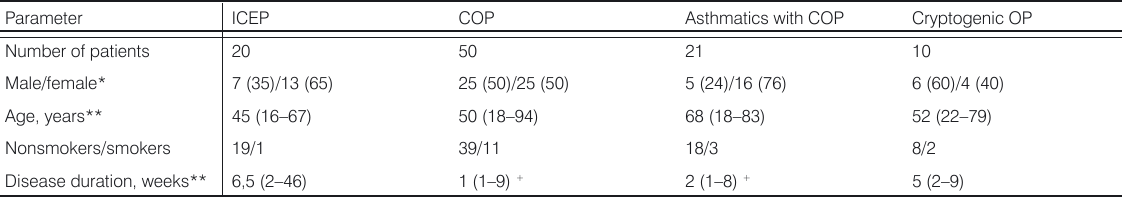
Table 2. Demographic data and duration of disease before diagnosis establishment of the patients of the study.